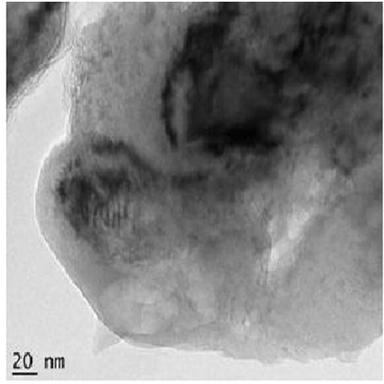
SAED pattern of RbCl doped MgO nanoparticle.